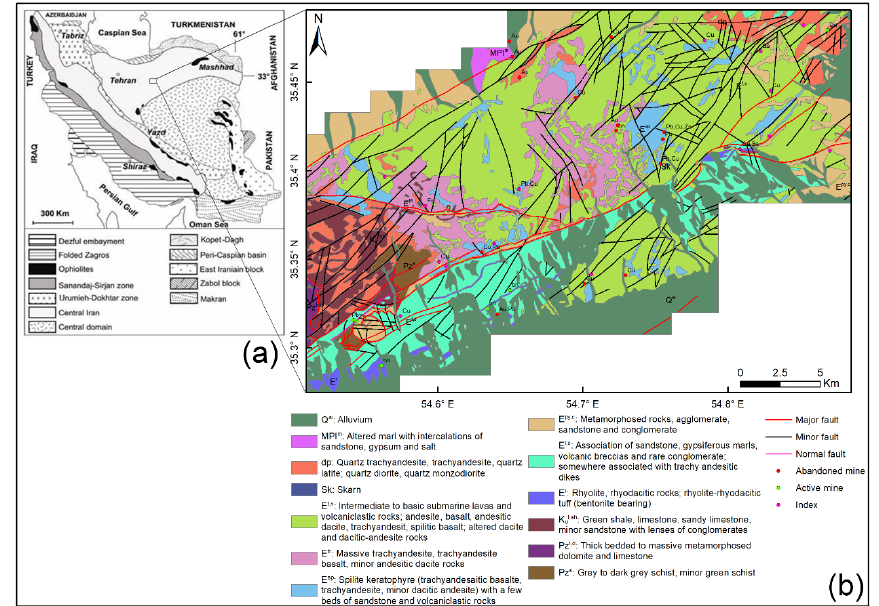
Figure 1. ( a ) Simplified tectonic scheme of Iran; and ( b ) geological map of the Toroud-Chahshirin range located in Central Iran